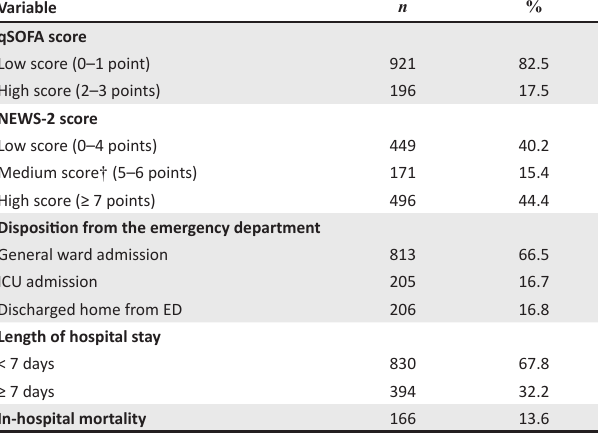
TABLE 5: Quick sequential organ failure assessment and national early warning score illness severity scores, patient disposition from the emergency department, length of hospital stay and in-hospital mortality amongst study